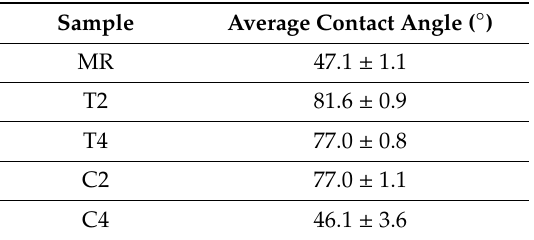
Table 3. Average contact angle values for the tested